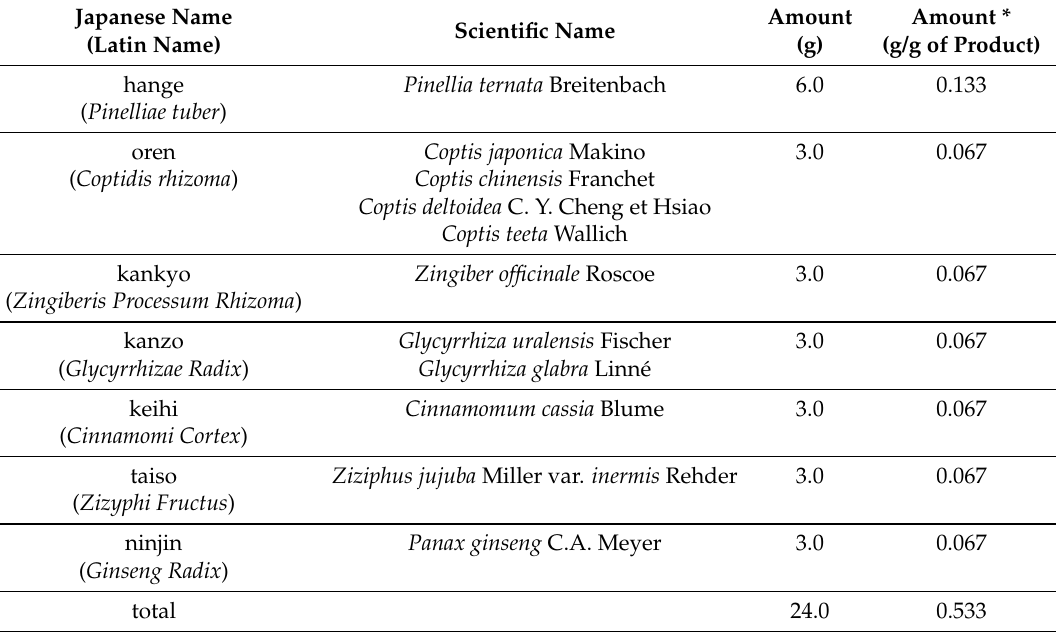
Table 7. The ingredients in the orento (TJ-120) formula.